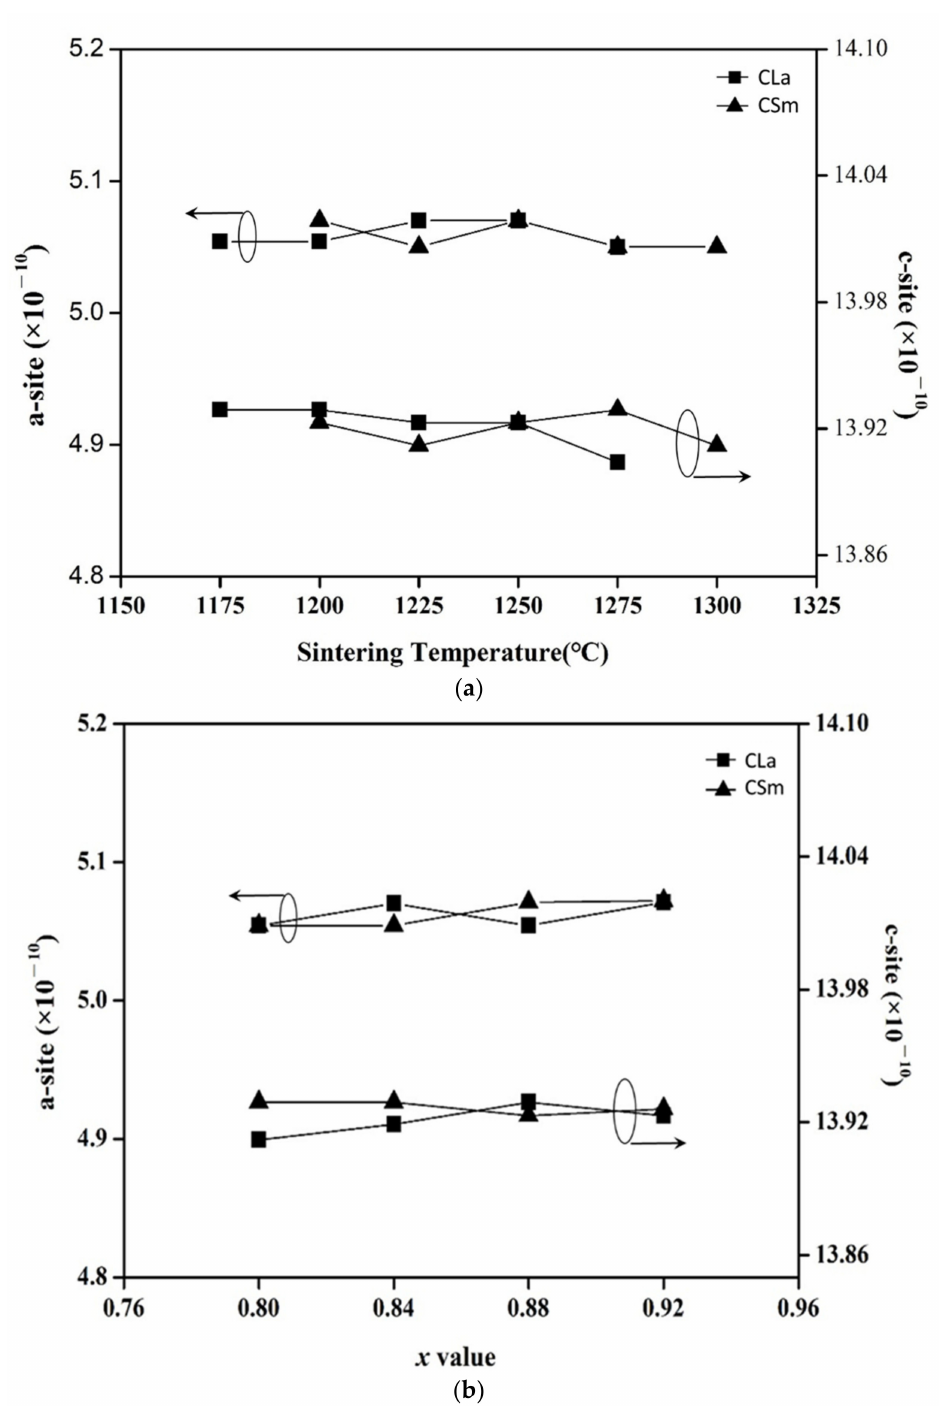
Figure 2. Lattice parameters of ( a ) 0.88(Mg 0.6 Zn 0.4 ) 0.95 Ni 0 . 05 TiO 3 -0.12Ca 0.6 La 0.8/3 TiO 3 /Ca 0.8 Sm 0.4/3 TiO 3 at various sin- tering temperature, ( b ) x(Mg 0.6 Zn 0.4 ) 0.95 Ni 0 . 05 TiO 3 -(1 − x) Ca 0.6 La 0.8/3 TiO 3 sintered at 1225 ◦ C and Ca 0.8 Sm 0.4/3 TiO 3 sintered at 1250 ◦